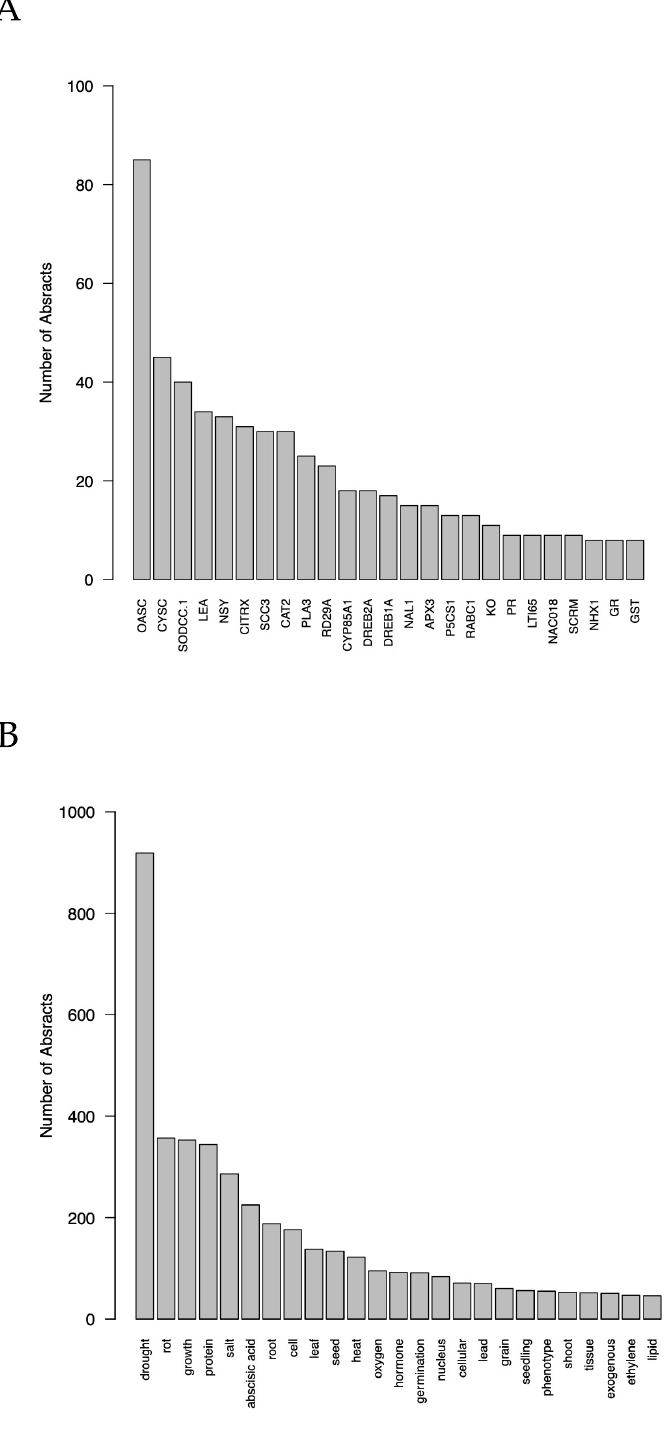
Figure 3. ( A ) Bar plot showing the top 25 genes involved in drought tolerance in plants based on our subset of abstracts inferred using GenesLookeR and MatchesBarPlotteR. ( B ) Bar plot showing the top 25 phenotypes involved in drought tolerance in plants based on our subset of abstracts inferred using PhenotypesLookeR and